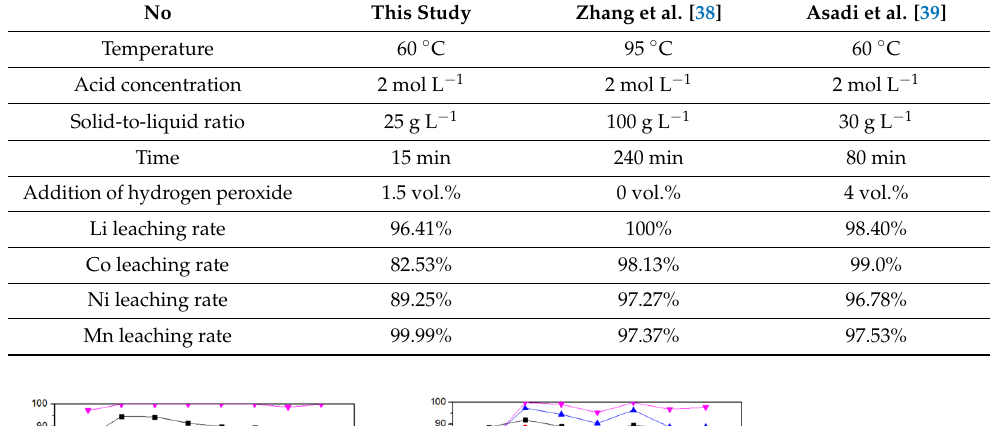
Table 3. Comparison of sulfuric acid leaching results.